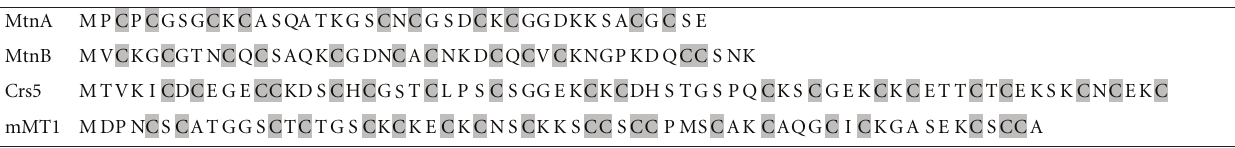
Table 1: Amino acid sequences of the four MT isoforms analyzed in this work. MtnA and MtnB are two Drosophila melanogaster isoforms. Crs5 is a Saccharomyces cerevisiae MT and mMT1 is the mouse MT isoform 1. The GST-based expression system used for recombinant synthesis added two N-terminal residues to these sequences (GS), which was previously shown not to influence the binding properties of MT peptides [7], but it has to be considered for the calculation of their theoretical molecular masses (Table 2, Figure